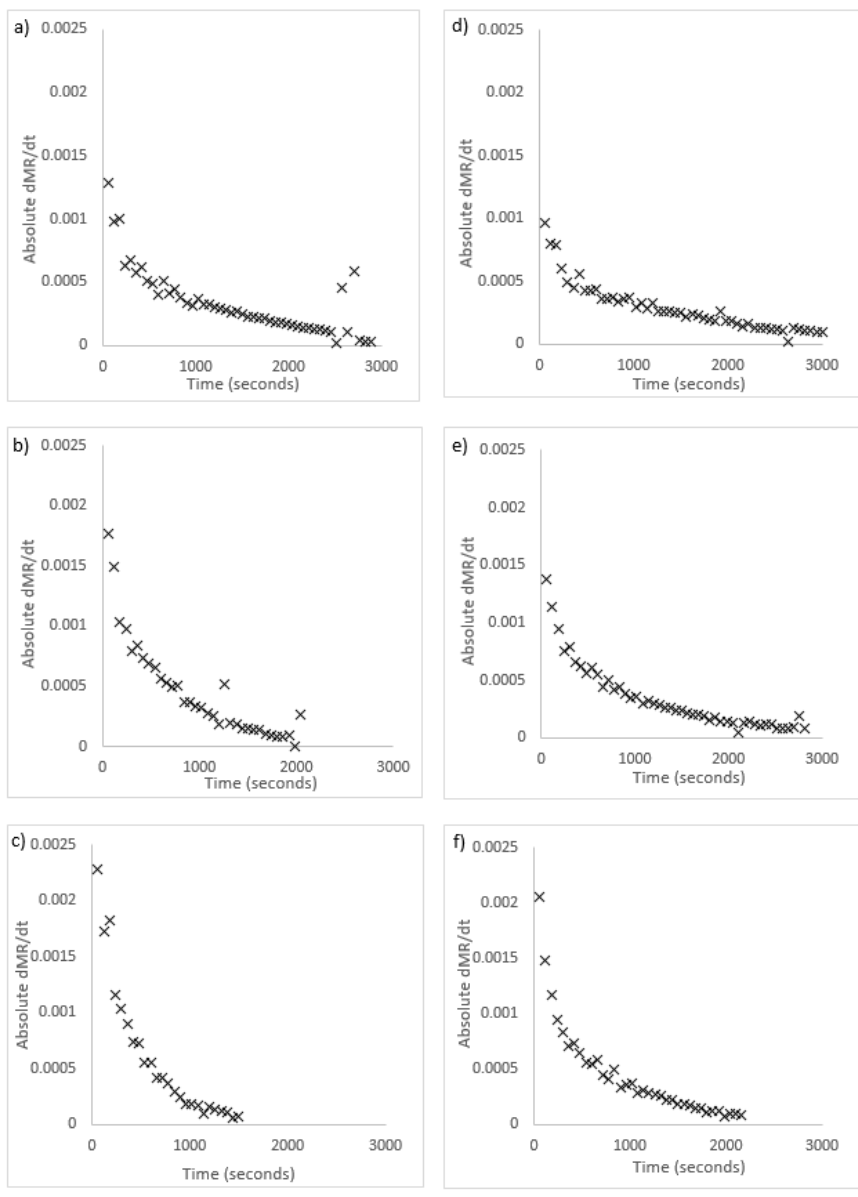
Figure 5. Dimensionless moisture ratio (MR) rate of change vs time for radiative drying; U. ohnoi ( a ) 40 °C ( b ) 50 °C ( c ) 60 °C; O. intermedium ( d ) 40 °C ( e ) 50 °C ( f ) 60 °C.